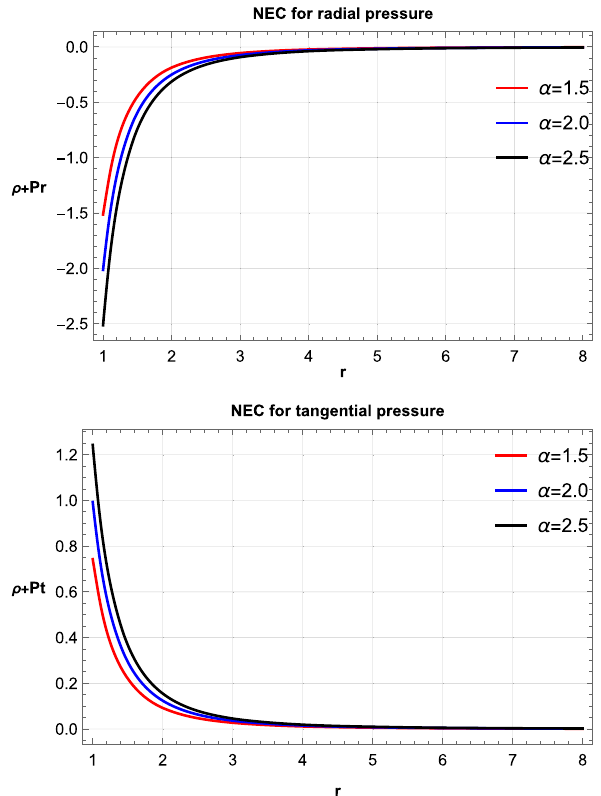
Fig. 3 The variation of NEC against r for parallel plates with r 0 = 1